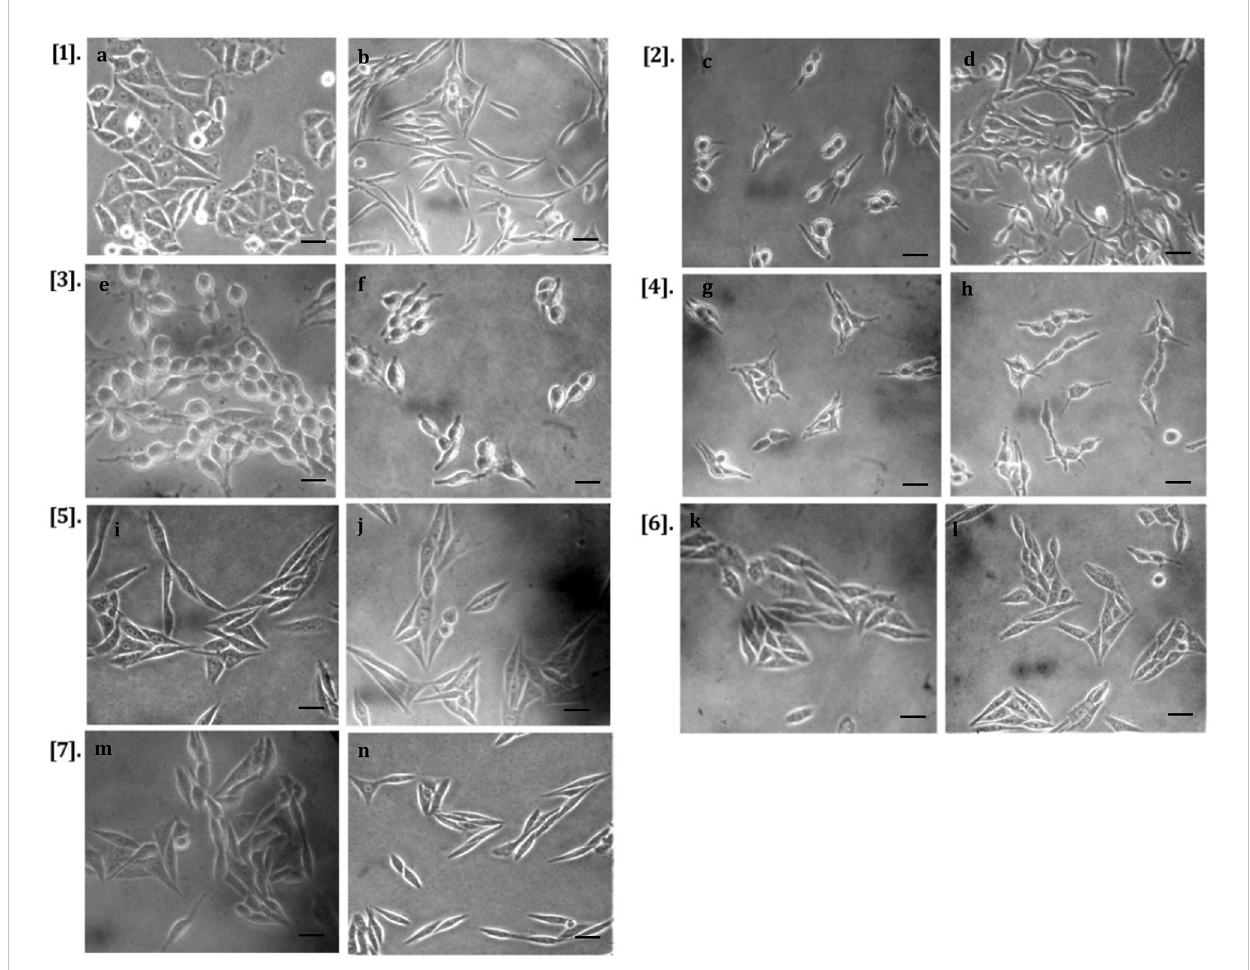
FIGURE 11 Protective activity against CT-induced cell elongation in CHO cell line. [1] (A) CHO cell control, (B) CFCF control (CT=100ng/mL); [2] (C) RTN (NC1) +CFCF, (D) RTN (NC2)+CFCF; [3] (E) PHD (NC1)+CFCF, (F) PHD (NC2)+CFCF; [4] (G) QRTN (NC1)+CFCF, (H) QRTN (NC2)+CFCF; [5] (I) EA (NC1) +CFCF, (J) EA (NC2)+CFCF; [6] (K) CHL (NC1)+CFCF, (L) CHL (NC2)+CFCF; [7] (M) GA (NC1)+CFCF, (N) GA (NC2)+CFCF at 40X magni fi cation (scale bar